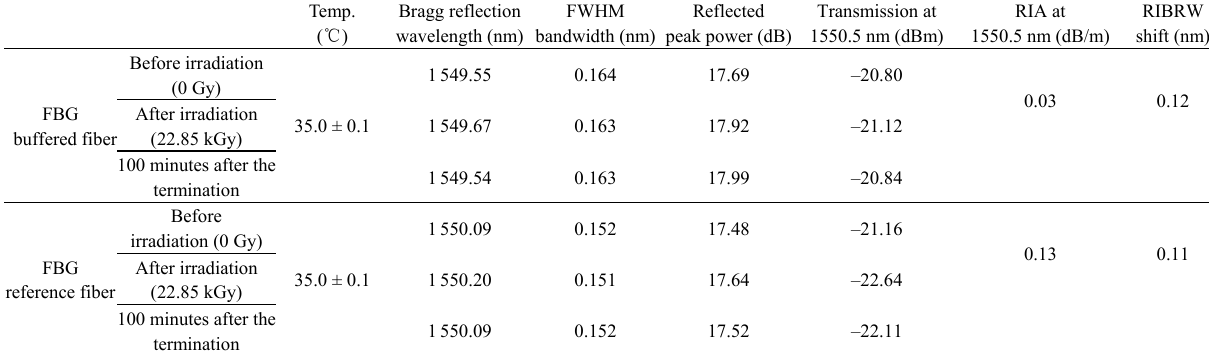
Table 2 Optical properties of the FBG fibers during and after the γ -ray irradiation. Temp.